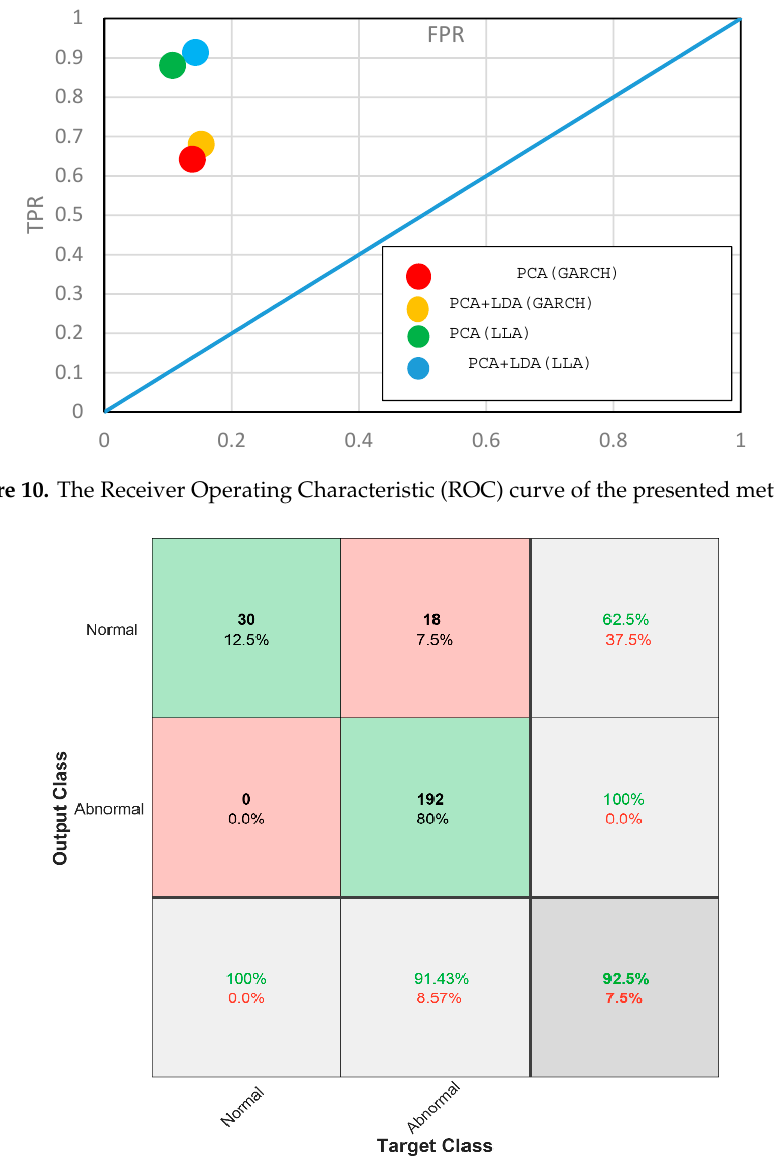
Figure 10. The Receiver Operating Characteristic (ROC) curve of the presented method.